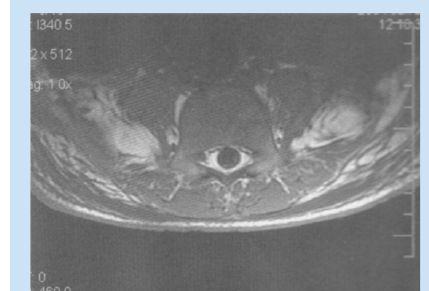
Fig. 8. Gibbs artefact (T1 sagittal study of the brain).